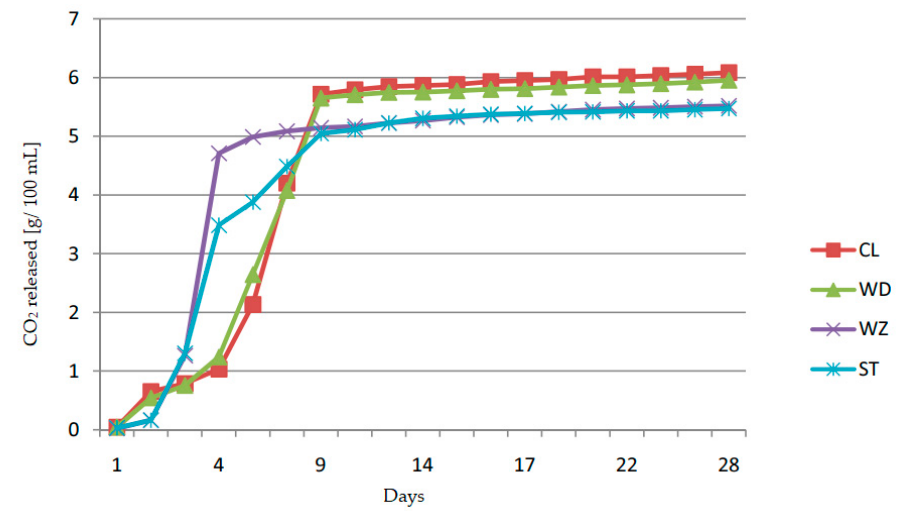
Figure 2. Fermentation dynamics of plum must fermented with S. cerevisiae S1, n = 5, STD < 5%. Abbreviations: CL— Č a č anska Lepotica, WD—W ę gierka D ą browicka, WZ—W ę gierka Zwyk ł a, ST—Stanley.